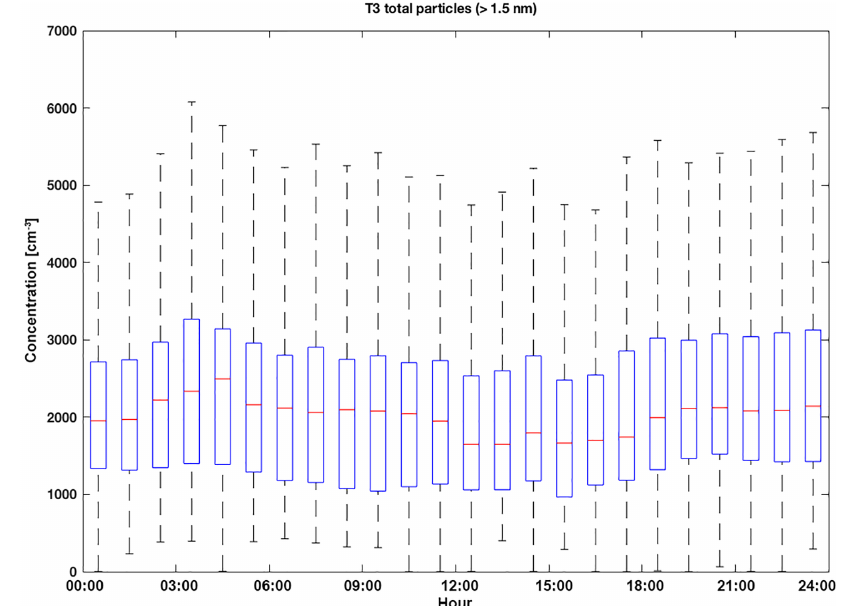
Figure 4. The diel cycle of particles bigger than 1.5nm measured by the PSM during the dry season at the pasture site is shown. In total, 38 days of data were used. The data show hourly median concentrations, the boxes represent the 25th and 75th percentiles, and the whiskers are 1 . 5 × IQR (interquartile range); data points beyond the whiskers are considered